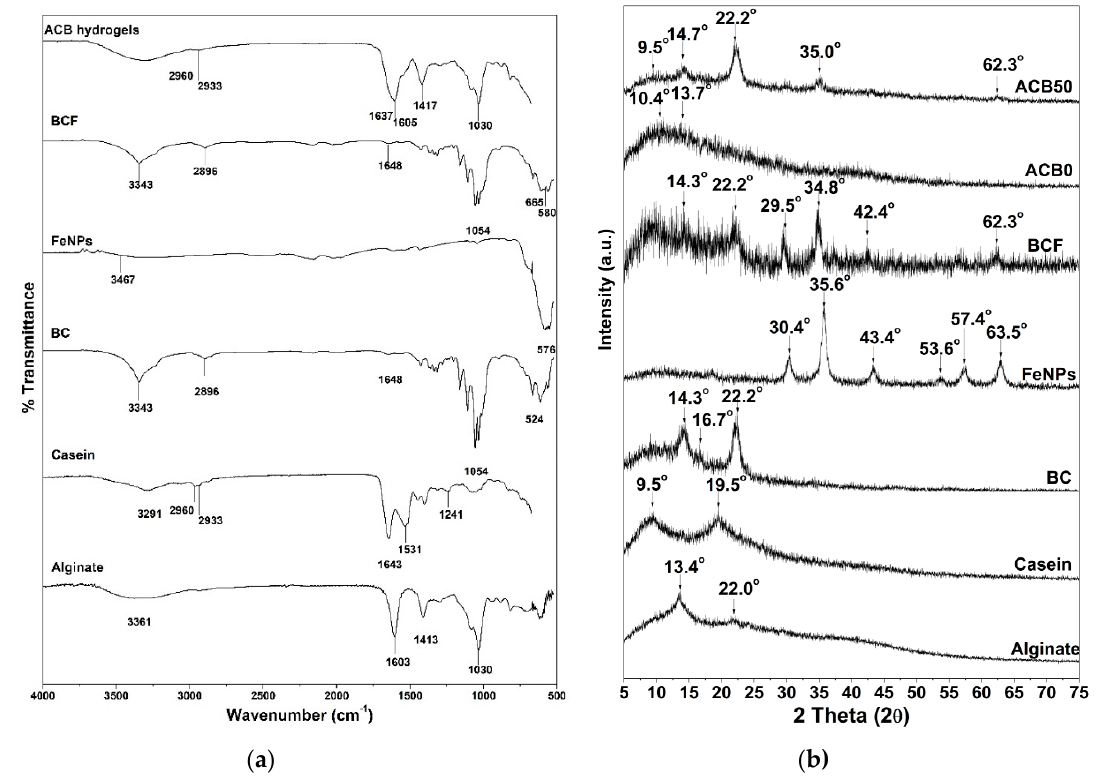
Figure 4. ( a ) Attenuated total reflectance (ATR) mode FTIR spectra and ( b ) X-ray diffractograms of synthesized FeNPs, BCF, free-dried ACB hydrogels, casein and alginate